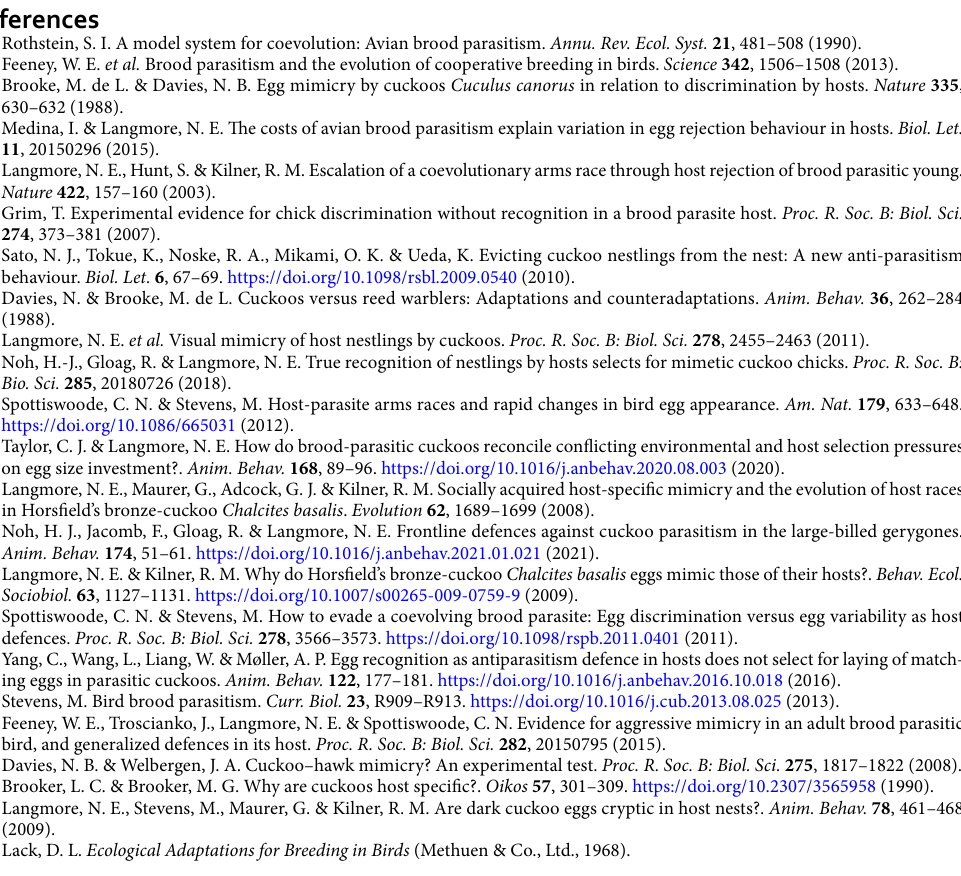
Fig. 1. We then tested whether host ejection behaviour predicted the ratio of cuckoo to host normalised eggshell thickness. We used a Restricted Maximum Likelihood Model (REML), with cuckoo:host normalised eggshell thickness ratio as the response variable, host response to foreign eggs (accept or eject) as the fixed effect and host species nested within cuckoo species as the random effect. For all models we checked standardised residuals for normality. Log 10 transformation of variables improved the normality of residuals (Anderson Darling Tests for Goodness-of-fit, all P > 0.4), so we present these results, although the qualitative results remained unchanged regardless of whether or not data were transformed. We ran four models; (1) eggshell thickness at the meridian including only hosts with known egg ejection rates, (2) eggshell thickness at the meridian including hosts with both known and unknown egg ejection rates, (3) eggshell thickness at the apex including only hosts with known egg ejection rates, and (4) eggshell thickness at the apex including hosts with both known and unknown egg ejection rates. The analyses were run in JMP v.15 (SAS Institute Inc,